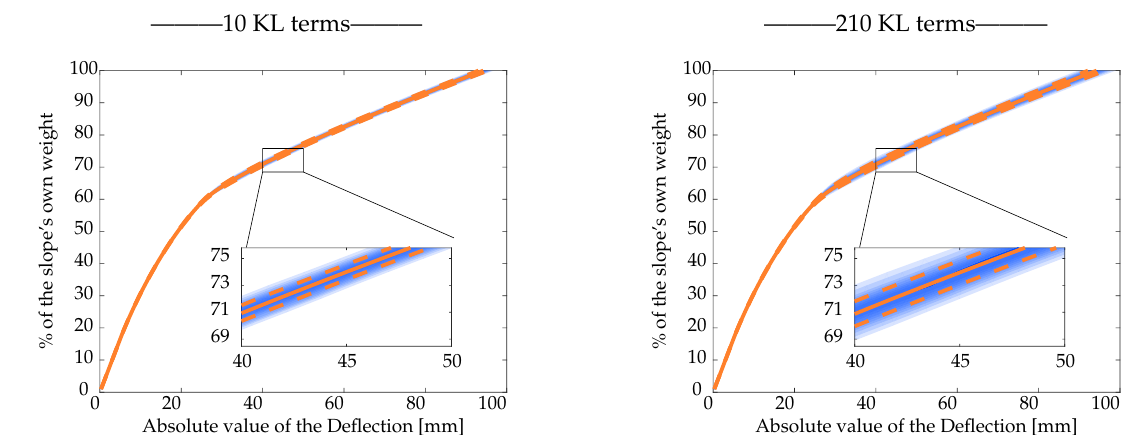
Figure 27. Uncertainty propagation towards the QoI’s for model problem 2.